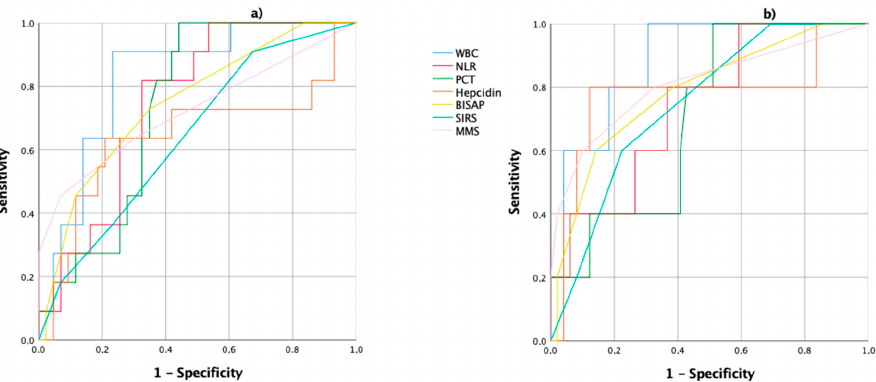
Figure 1. Receiver operating characteristics (ROC) curves of the WBC: white blood count; NLR: neutrophil/lymphocyte ratio; PCT: procalcitonin; hepcidin; BISAP: bedside index of severity in acute pancreatitis; SIRS: systemic inflammatory response syndrome; and the MMS: modified Marshall score, on admission; ( a ) the ROC curves for the prediction of acute biliary pancreatitis severity; ( b ) the ROC curves for the prediction of acute biliary pancreatitis